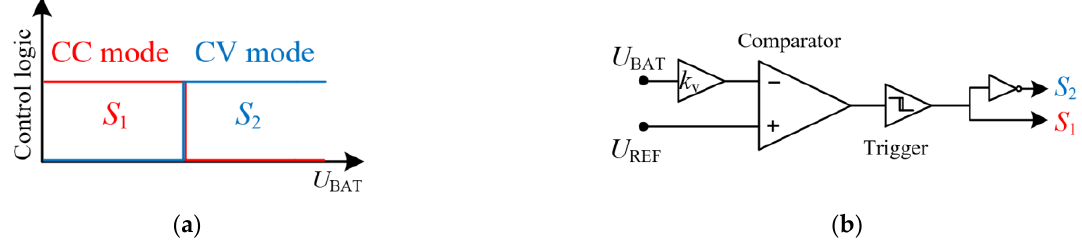
Figure 12. ( a ) Control logic for S 1 and S 2 of the battery charger and ( b ) circuit diagram for performing the switching action.